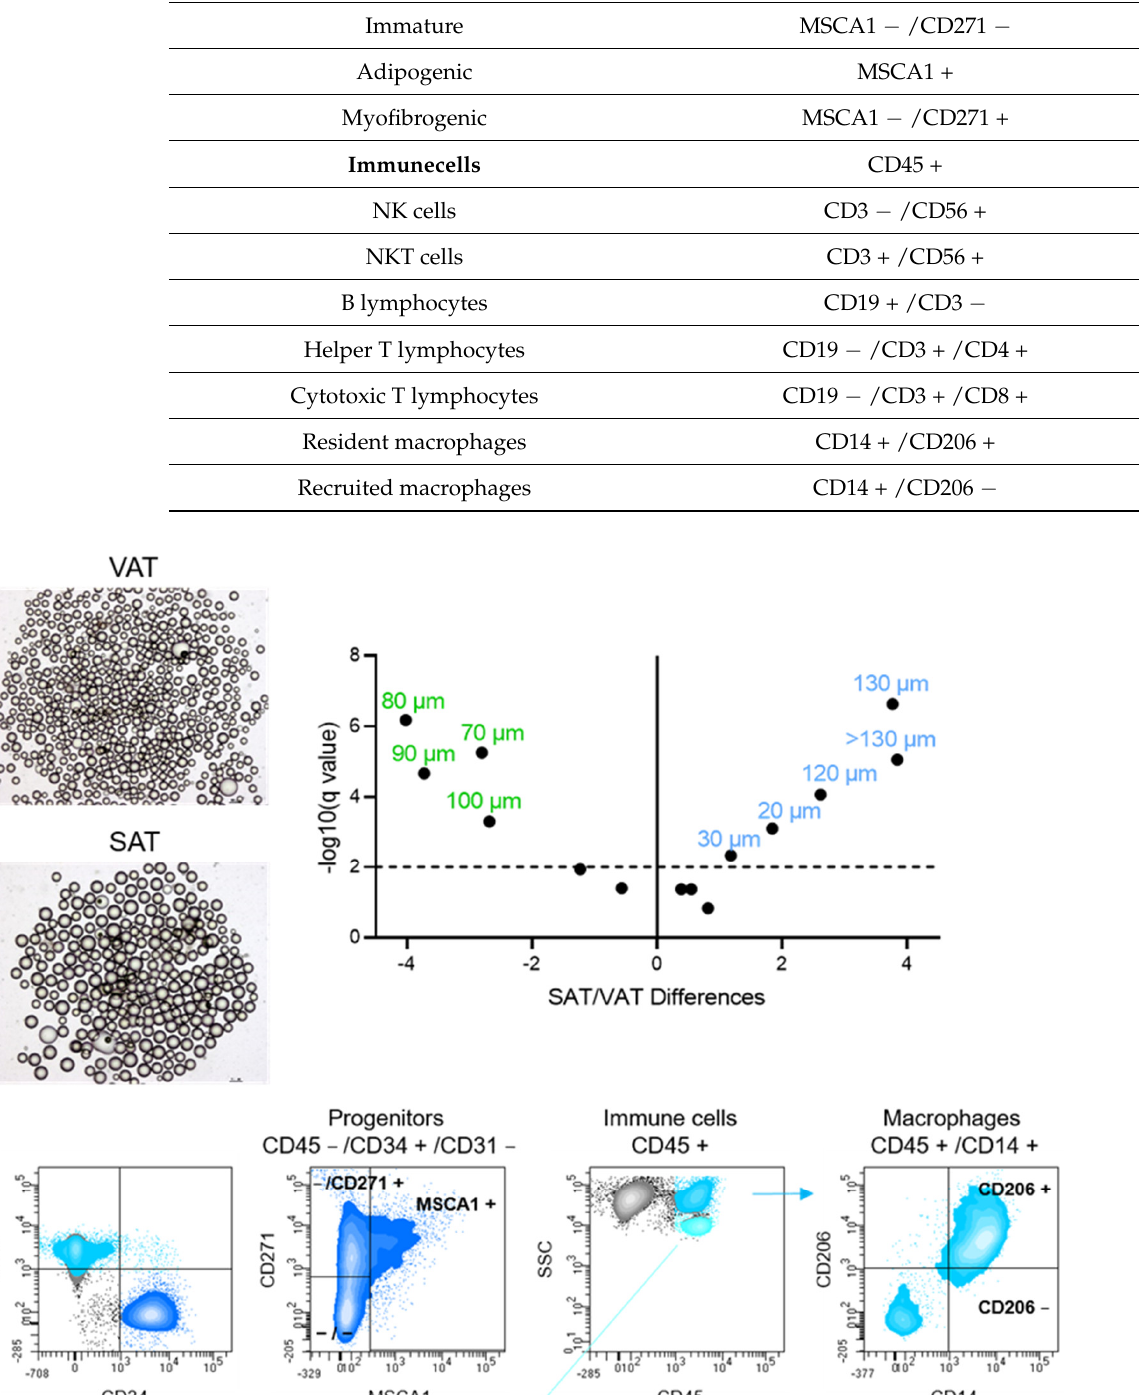
Figure 1. Differences in adipocyte size and stroma cell numbers between SAT and VAT. ( A ) Repre- sentative phase microscopy photography of VAT and SAT adipocytes are shown. Volcano plot of